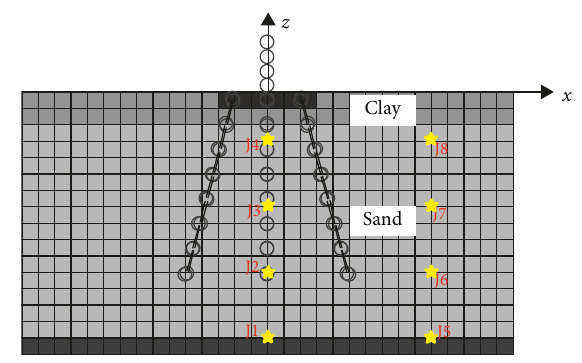
Figure 2: Numerical simulation model corresponding to two soil layers.